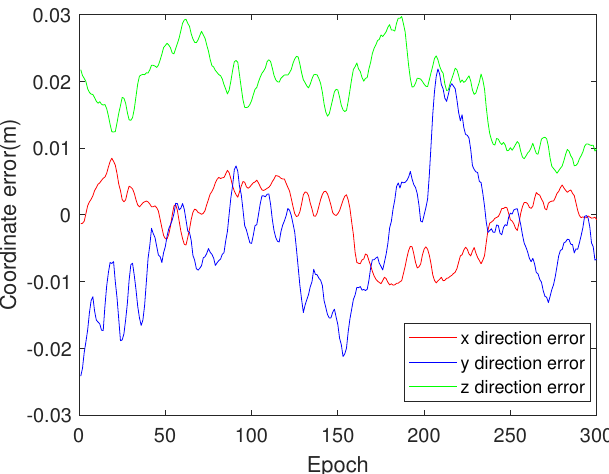
Figure 7. Coordinate identification error with LAMBDA-GWO (baseline 1).